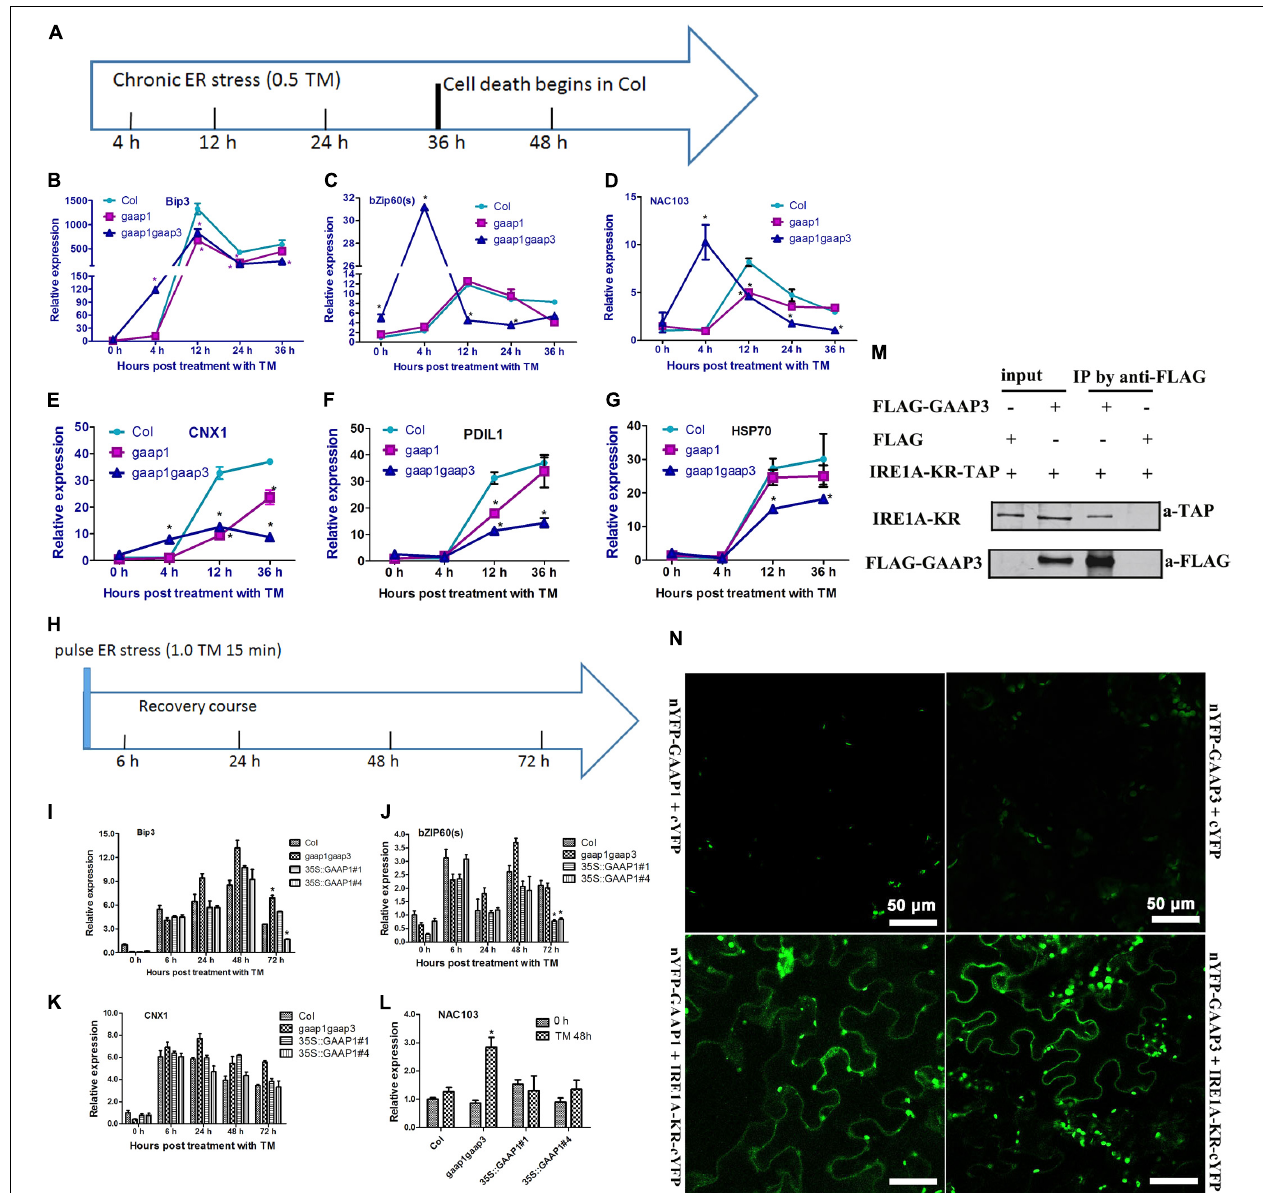
FIGURE 7 | Expression levels of GAAP1 and GAAP3 affected the UPR gene pattern over the time course of chronic ER stress or during the recovery of ER stress through the association with IRE1. (A–G) The change pattern of UPR genes in Col, gaap1-1 , and gaap1gaap3 plants upon chronic ER stress induced by 0.5 µ g mL − 1 TM, and the treatment condition is shown in (A) . Transcript levels of selected ER marker genes were quantified by qRT–PCR. Value of each control of Col was set at 1. (H–L) GAAP1 enhanced the decline of UPR gene mRNA during ER stress recovery. Total RNA was isolated from 7-day-old Arabidopsis seedlings that were vacuum infiltrated with 1/2 MS liquid salt containing 1.0 µ g mL − 1 TM for 15 min and then recovered for 6, 24, 48, and 72 h on the medium, and the treatment condition is shown in (H) . Seedlings before vacuum infiltration with TM were used as 0 h. Transcript levels of selected ER marker genes were quantified by qRT–PCR. Value of each gene in Col at 0 h is set at 1. Data are from three to four biological replicates ( ± SD). Asterisks refer to significant differences from Col at the same time points ( p < 0.05). (M) GAAP3 interacted with the region containing the kinase and endoribonuclease domains of Arabidopsis IRE1A (IRE1A-KR) in tobacco leaf cells assayed by Co-IP. (N) GAAP1 and GAAP3 interacted with IRE1A, as shown by BiFC assay. YFP fluorescence was observed when nYFP- GAAP1/GAAP3 and IRE1A-KR-cYFP were co-expressed in the tobacco leaf cell (bottom images), whereas only the background signal of chlorophyll was observed when nYFP- GAAP1/GAAP3 and cYFP were co-expressed (top images), or IRE1A-KR-cYFP and nYFP were co-expressed (not